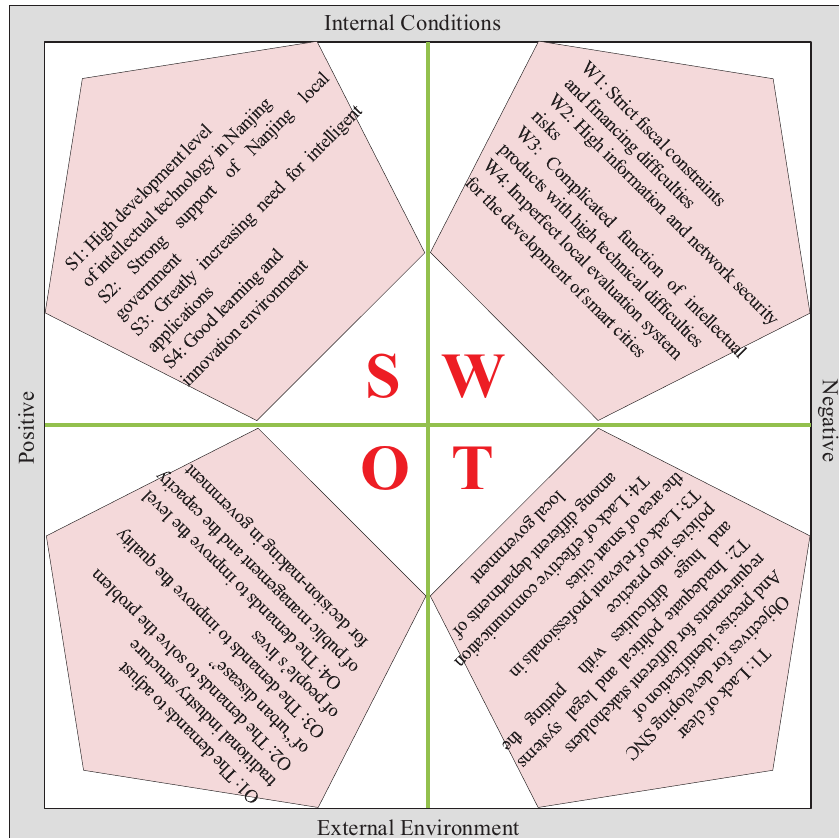
Figure 5. The SWOT